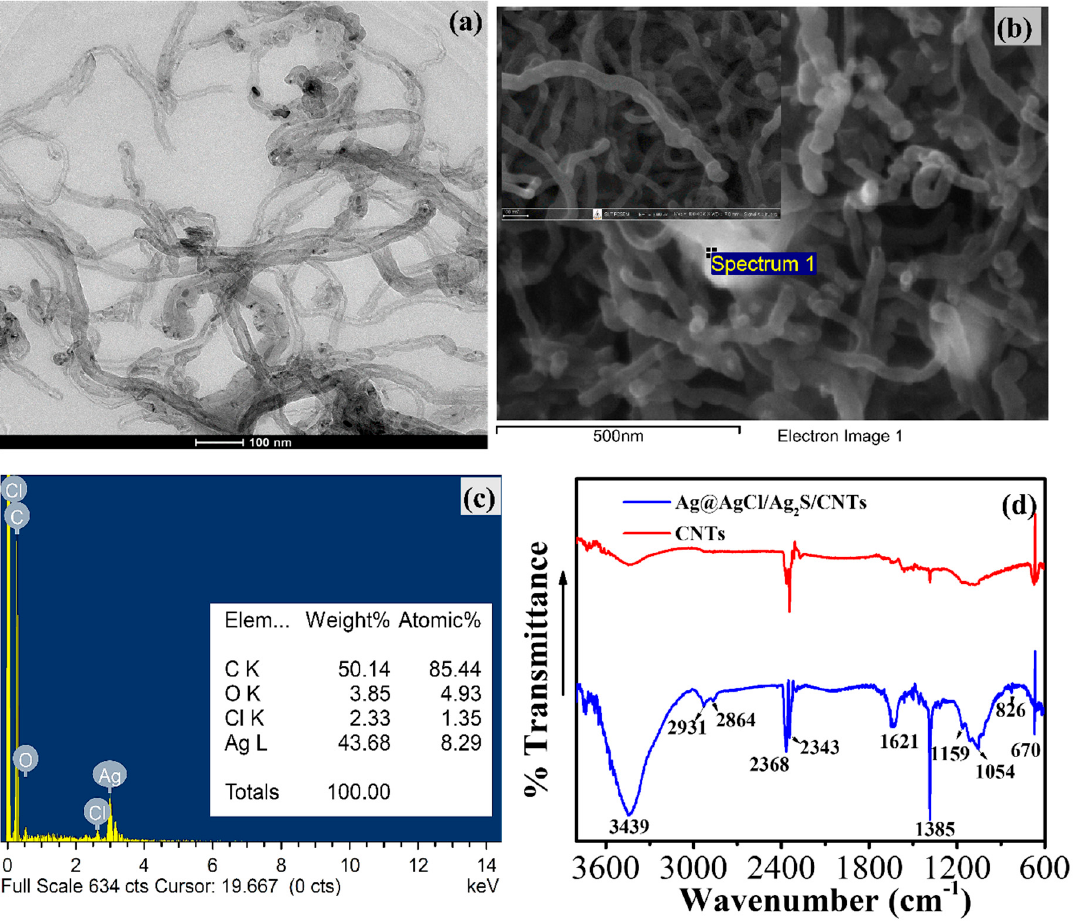
Figure 1. ( a ) TEM image of Ag@AgCl / Ag 2 S / CNTs; ( b ) SEM images of Ag@AgCl / Ag 2 S / CNTs at low-magnification and higher-magnification (inset); ( c ) with the energy dispersive X-ray (EDS) spectrum, ( d ) FTIR spectrum of Ag@AgCl / Ag 2 S / CNTs.